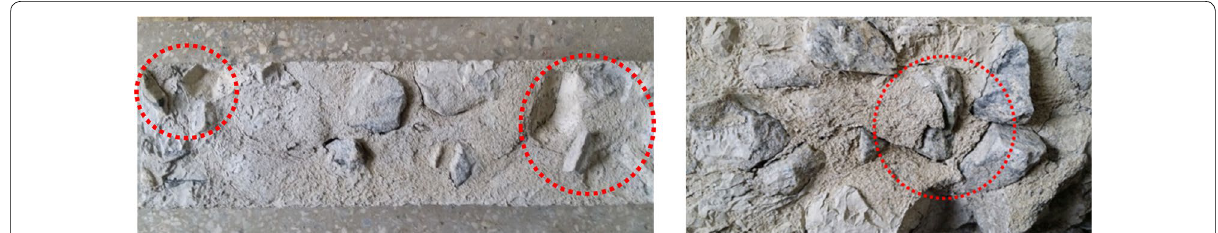
Fig. 3 Interfacial failure between recycled ballast aggregates and mortar in freezing–thawing tests (Yoo et al. 2016).